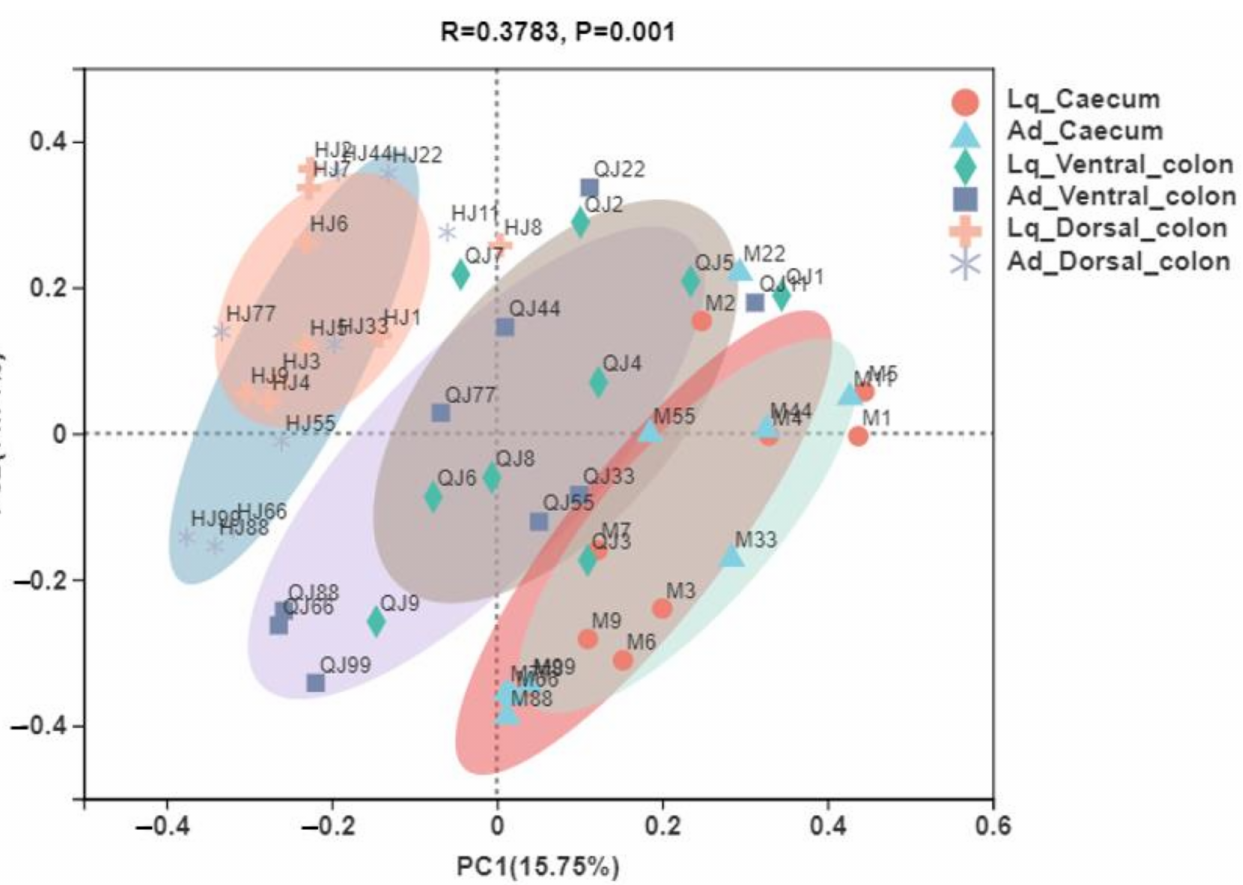
Figure 4. Principal coordinate analysis (PCoA) of bacterial community structures in the liquid phase (Lq) and adherent fraction (Ad) within the donkey caeco-colic